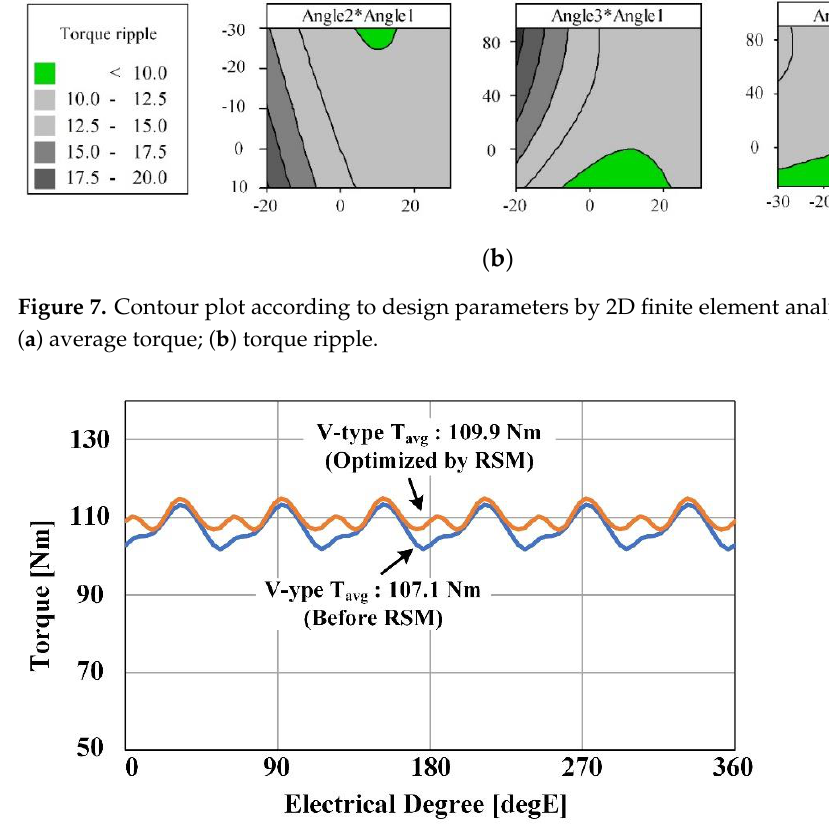
Figure 8. Torque wave form with the optimized barrier angles.